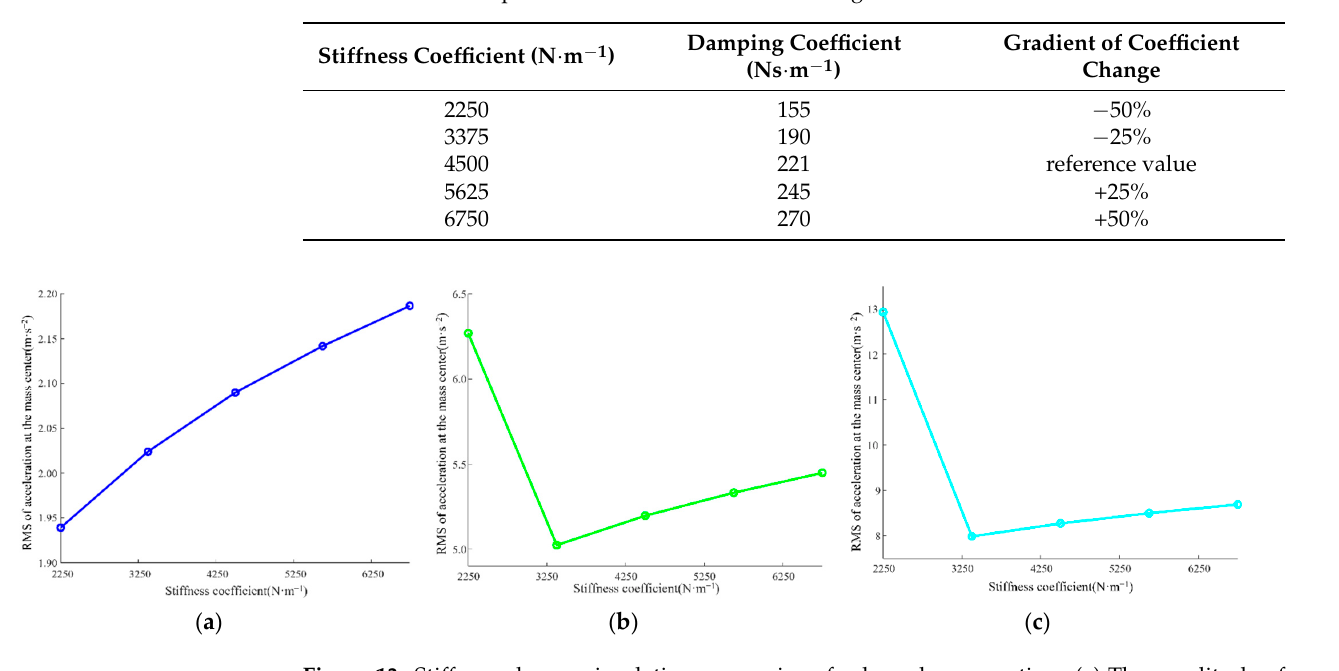
Table 3. Simulation parameters of stiffness value for large heave motion.